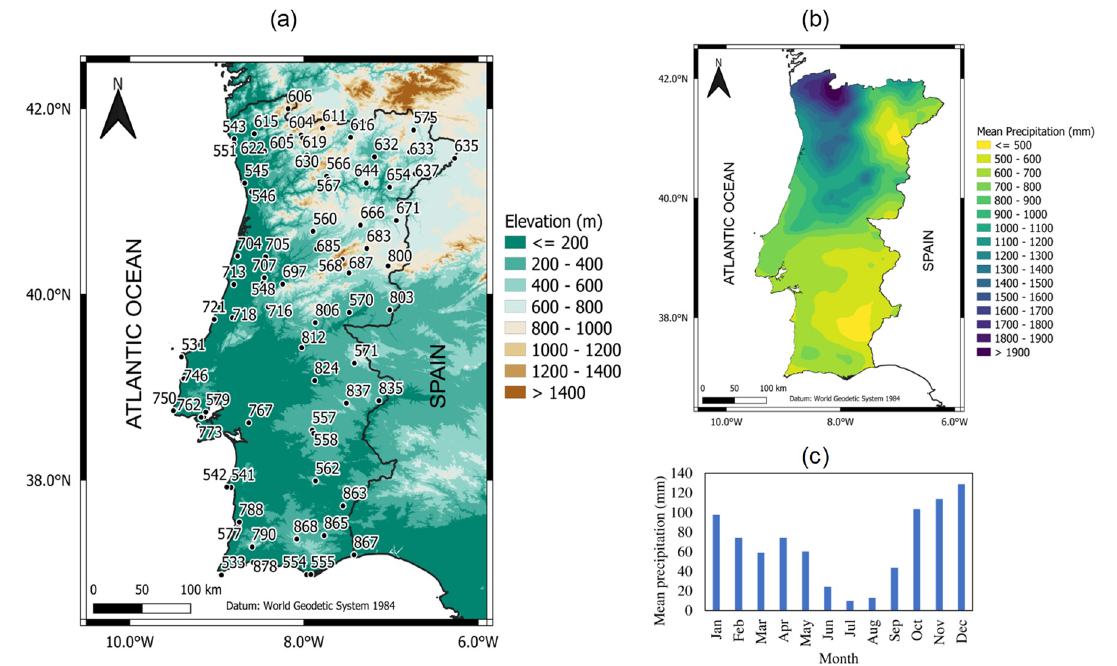
Figure 1. ( a ) Hypsometric chart of mainland Portugal (elevation in m), along with the 71-weather- station network (data selected within the period of 2000–2020 (21 years)) of sub-hourly data (10- minute timescale). Stations are labeled according to their corresponding IPMA codes (cf. Table S1). Data source: IPMA. ( b ) Mean annual total precipitation (in mm) over mainland Portugal (baseline: 1981–2010). Data source: IBERIA01 [48] . ( c ) Bar chart showing the climate-mean monthly total precipitation averaged over mainland